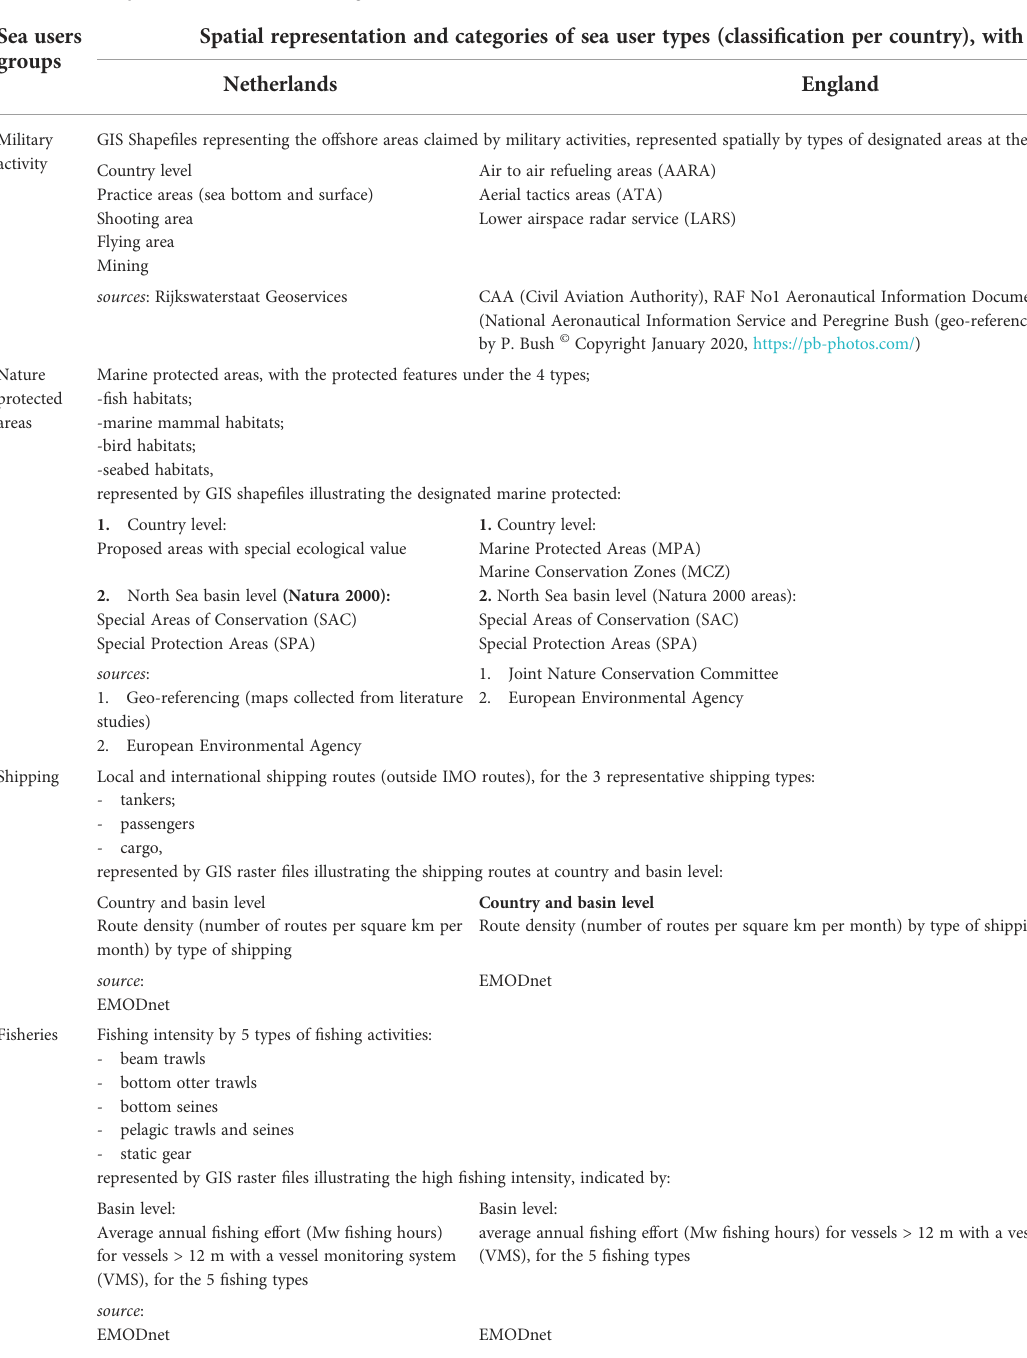
TABLE 2 Geo-spatial data base for the analyzed activities with used indicators. Sea users groups